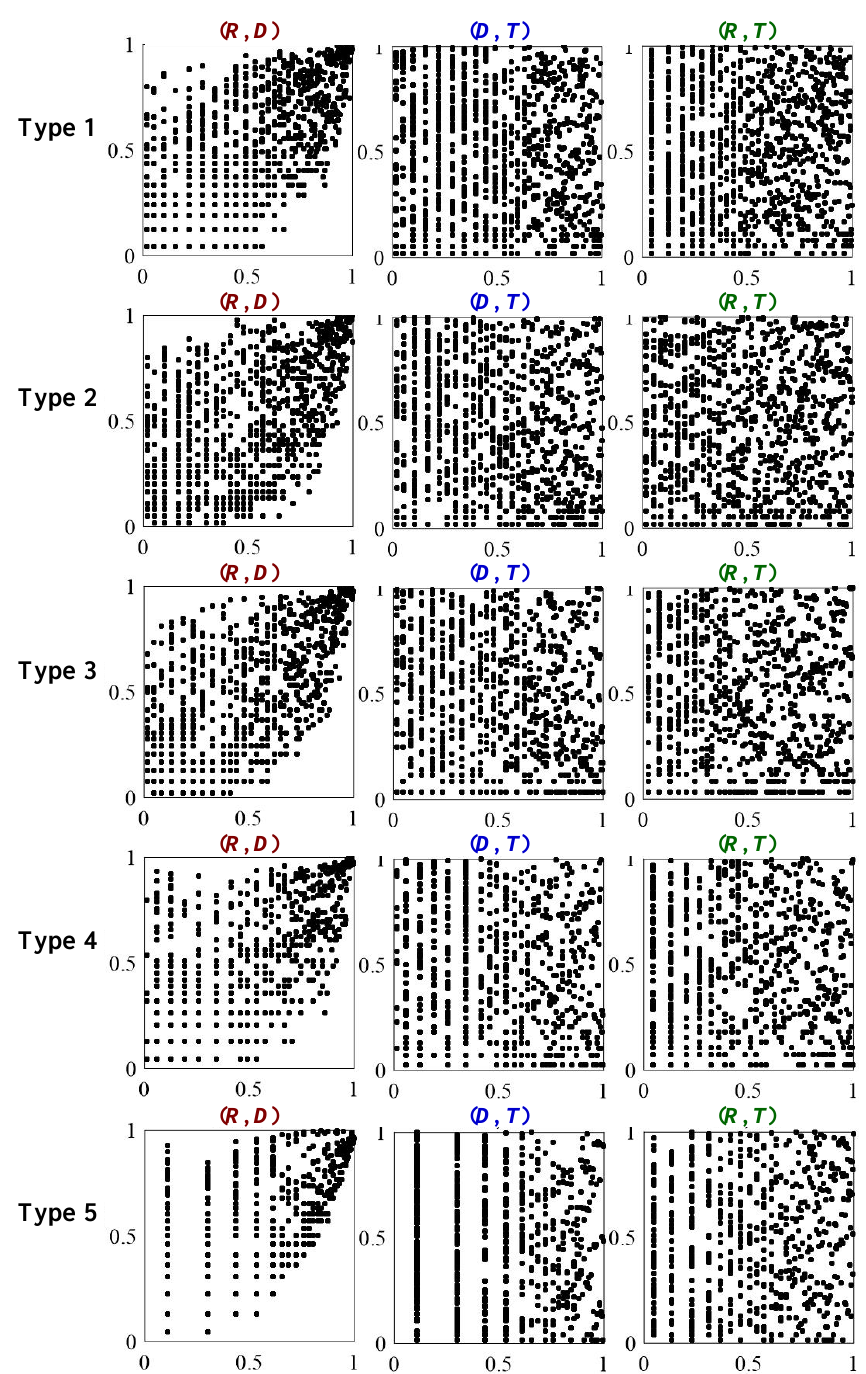
Figure 8. Normalized-rank scatter plots for different pairs of rainfall parameters in summer.